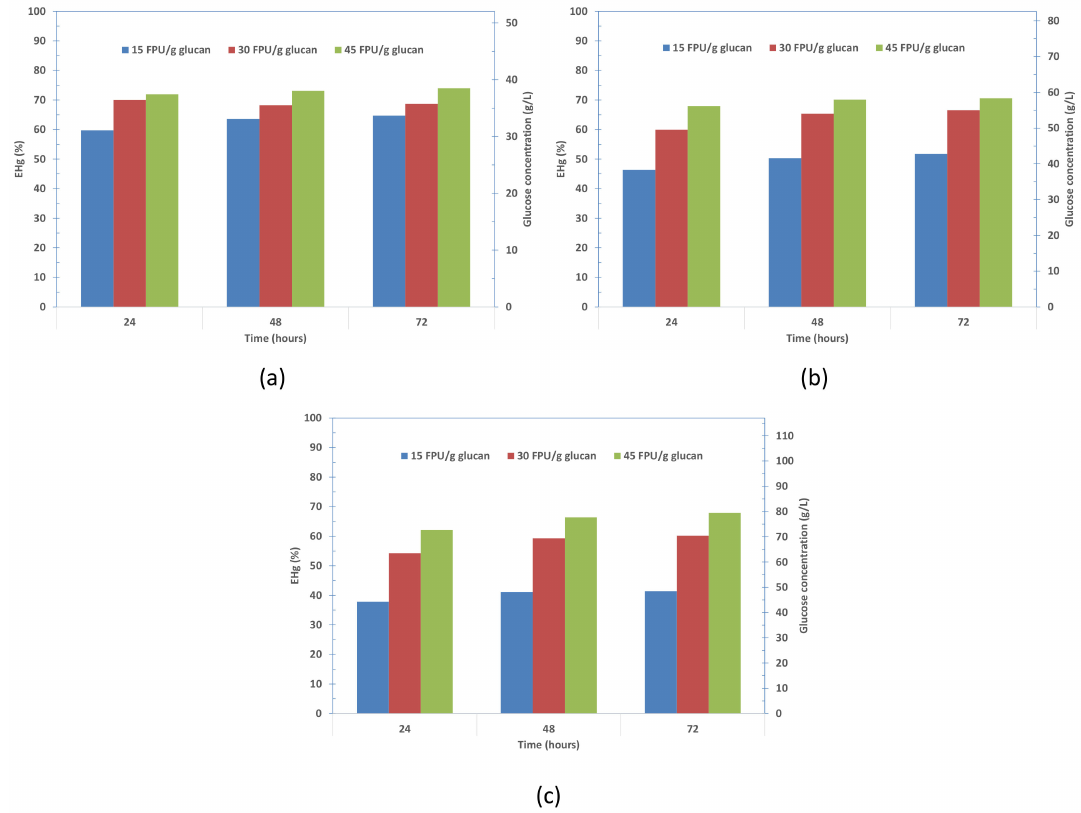
Figure 4. Enzymatic Hydrolysis yield (%) during the DA-SE MFUW pretreated at 15, 30, and 45 FPU / g glucan: ( a ) 10% DM solid consistency; ( b ) 15% DM solid consistency; and ( c ) 20% DM solid